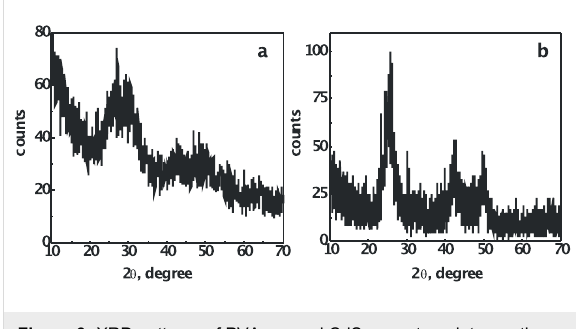
Figure 6: XRD patterns of PVA-capped CdSe quantum dots, synthe- sized by the reaction of (a) 2 × 10 − 3 mol dm − 3 Cd(AcO) 2 with 1 × 10 − 3 mol dm − 3 Na 2 SeSO 3 , and (b) 2 × 10 − 3 mol dm − 3 Cd(AcO) 2 with 8 × 10 − 3 mol dm − 3 Na 2 SeSO 3 , in the presence of 9.2% PVA, after 48 h of